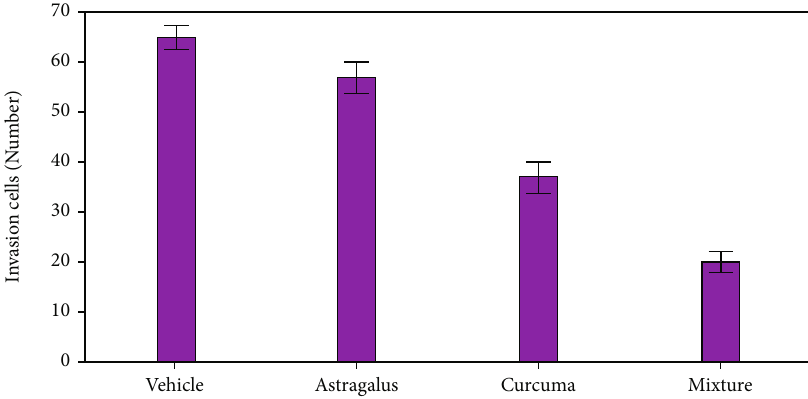
Figure 11: Curcuma or mixed solution but not the Astragalus reduced the invasion of